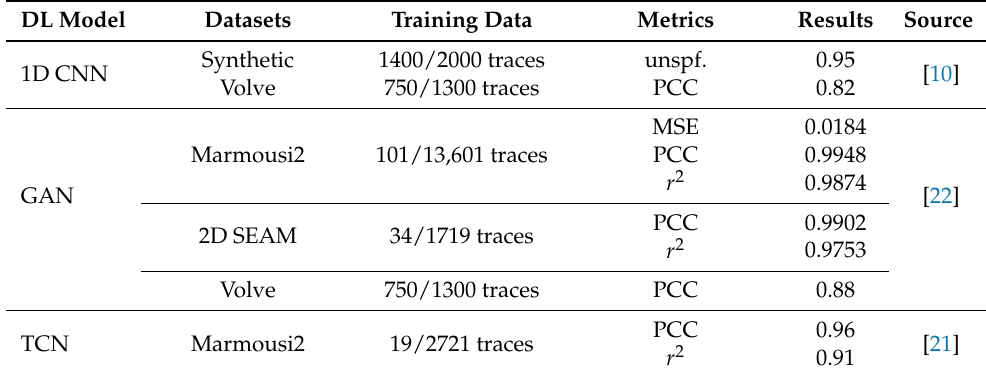
Table 1. Summary of each experiment described in this